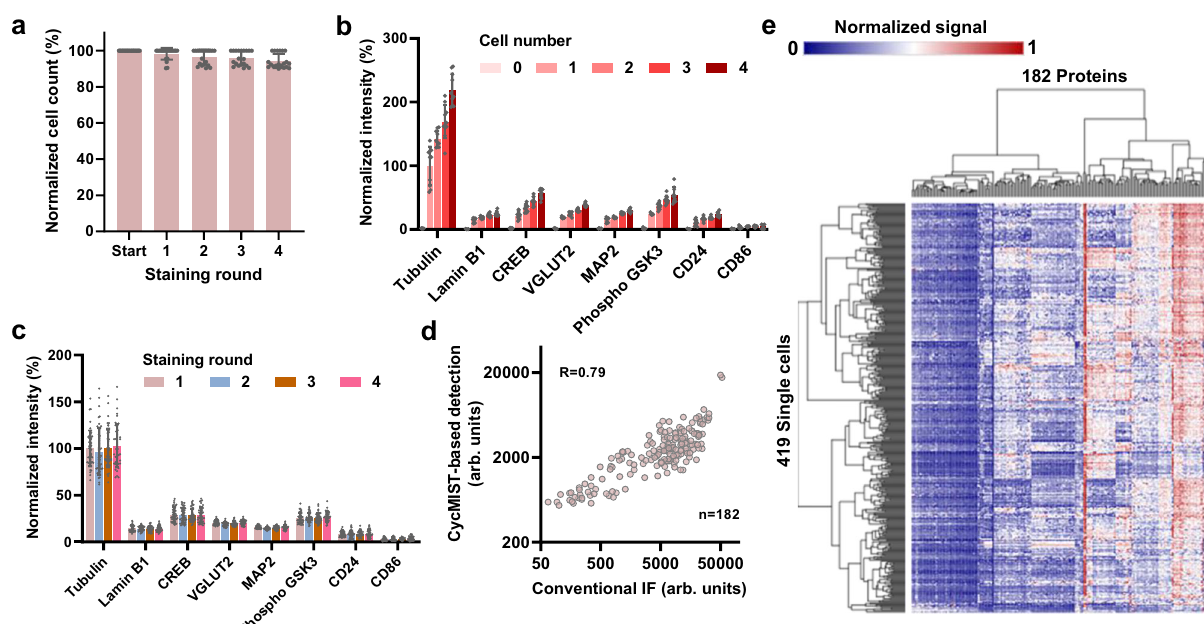
Fig. 3 Single-cell CycMIST assay on N2a cell line. a Quanti fi cation of cell loss through 4 rounds of the assay on the same cells in the PDMS microwells. Error bars represent 20 times of repeats. b Assay sensitivity for increased number of cells loading in microwells. Error bars are standard deviations of signals from 10 independent microwells. c Reproducibility of CycMIST analysis of 8 proteins for 4 staining rounds on the same single cells. Error bars are standard deviations of signals from 43 single cells. d Correlation of 182 protein expression levels between the single-cell averages measured by CycMIST and the population levels measured by conventional immuno fl uorescence staining methods. The CycMIST-based signal is obtained by averaging the signal of 100 single cells. The correlation coef fi cient R equals 0.79 for the two methods. e Heatmap of unsupervised clustering result of a single-cell CycMIST assay using a whole panel of 182 proteins with 4 staining rounds. Both rows and columns are clustered by Euclidean distance and complete linkage. Data are presented as mean values ± SD of more than three independent experiments, and error bars are within symbol size if not shown. The term (arb. units) is abbreviated for arbitrary